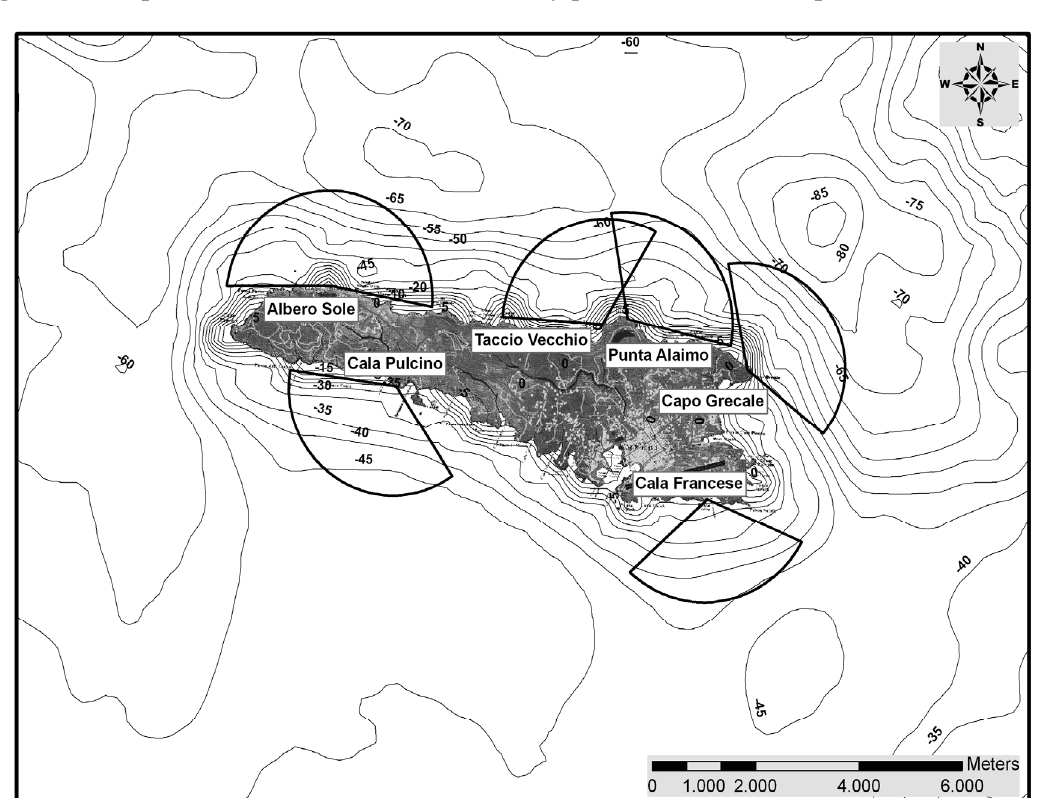
Figure 1. Lampedusa Island and land-based survey positions with their open view sea